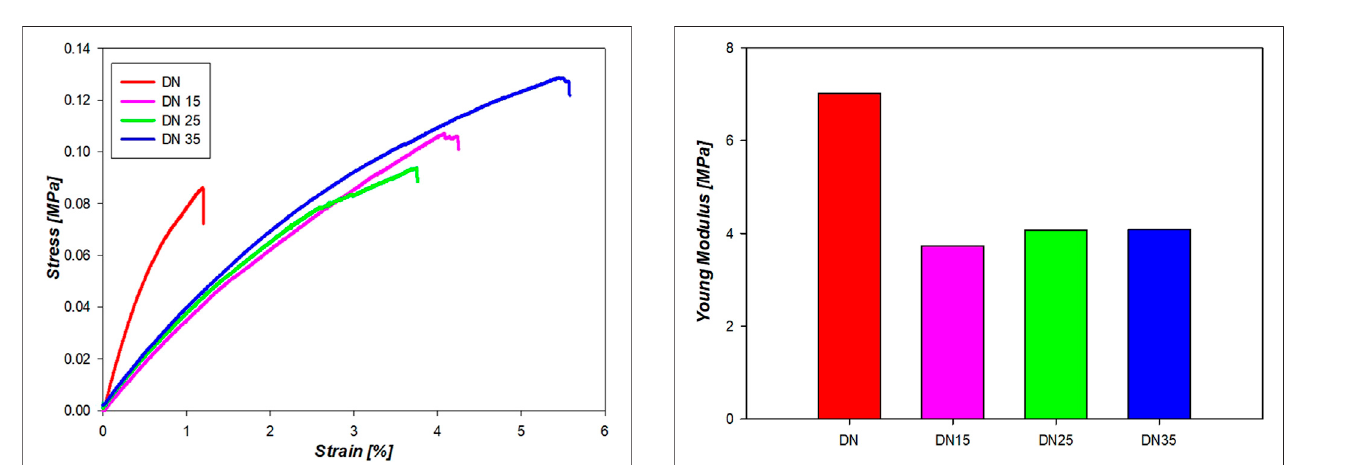
FIGURE10| Mechanicalpropertiesofthedoublenetworksolutioninthe dumbbell shape.